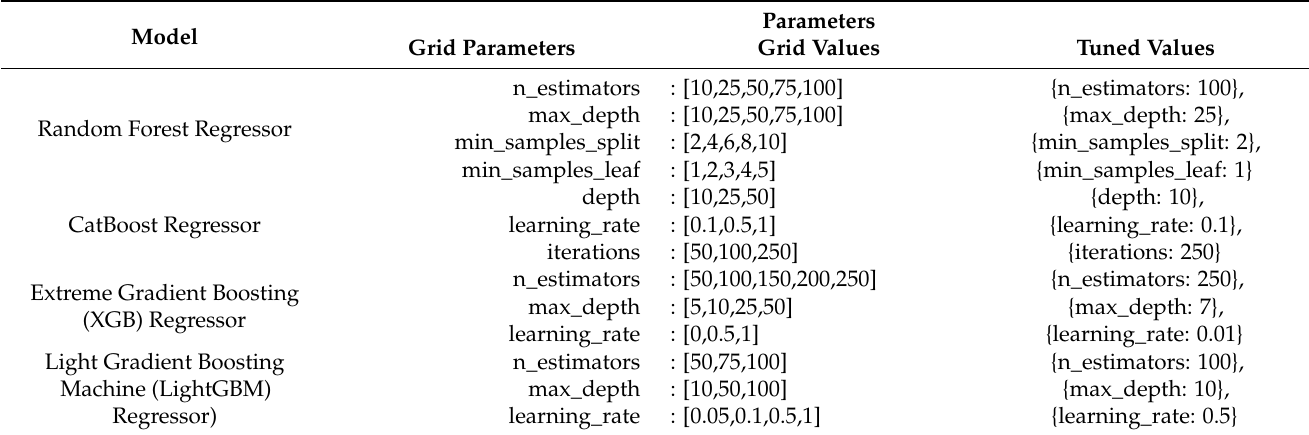
Table 7. Hyperparameter tuning attribution.